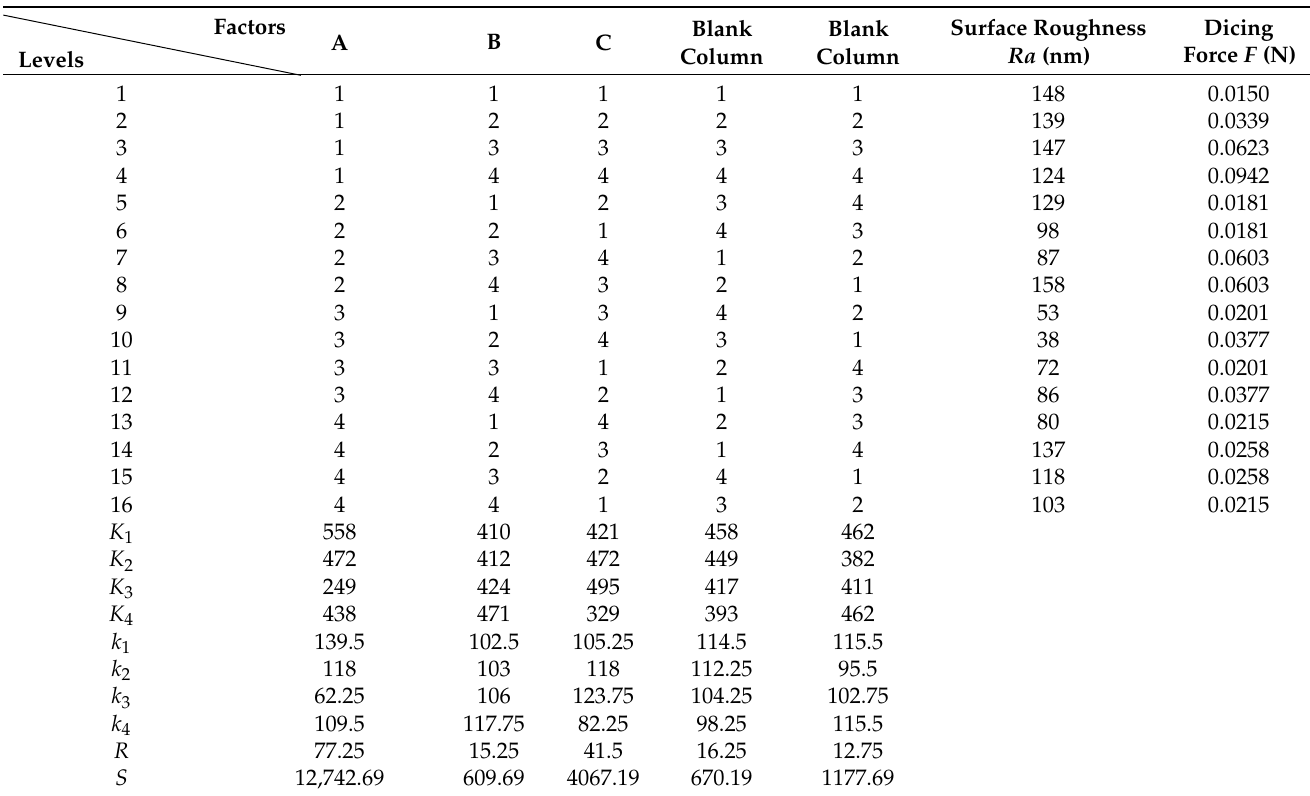
Table 4. Surface quality Ra and dicing force F of AFRP